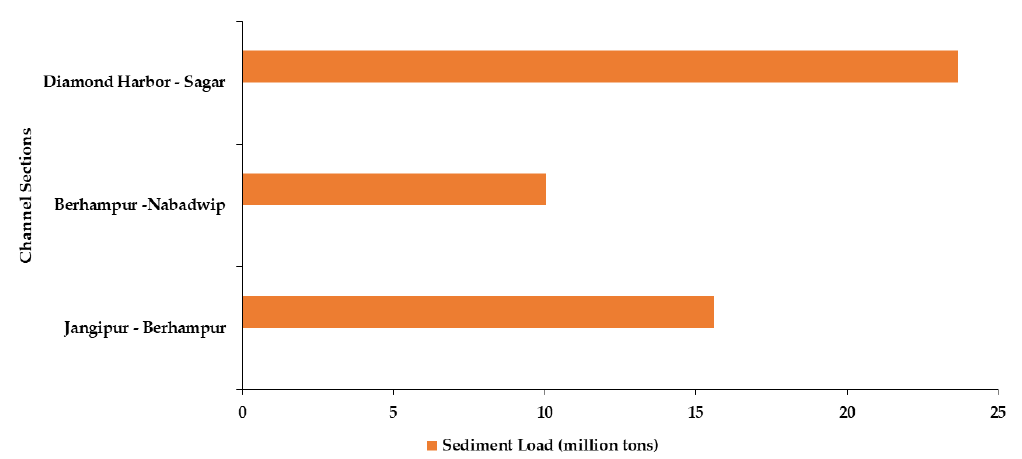
Figure 6. Sediment load taking place at various channel sections calculated by Rudra [92]. The lo- calisation of the selected sections shows in Figure